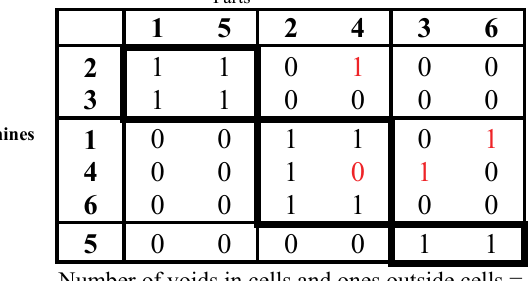
Fig. 3. Second optimal solution for Mukattash